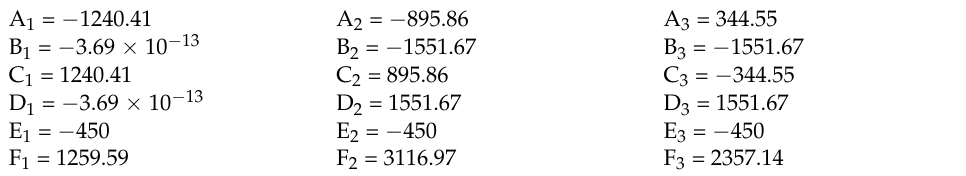
Table 6. Coefficients of the Equations (4)–(6) for the planar manipulator. A 1 = −